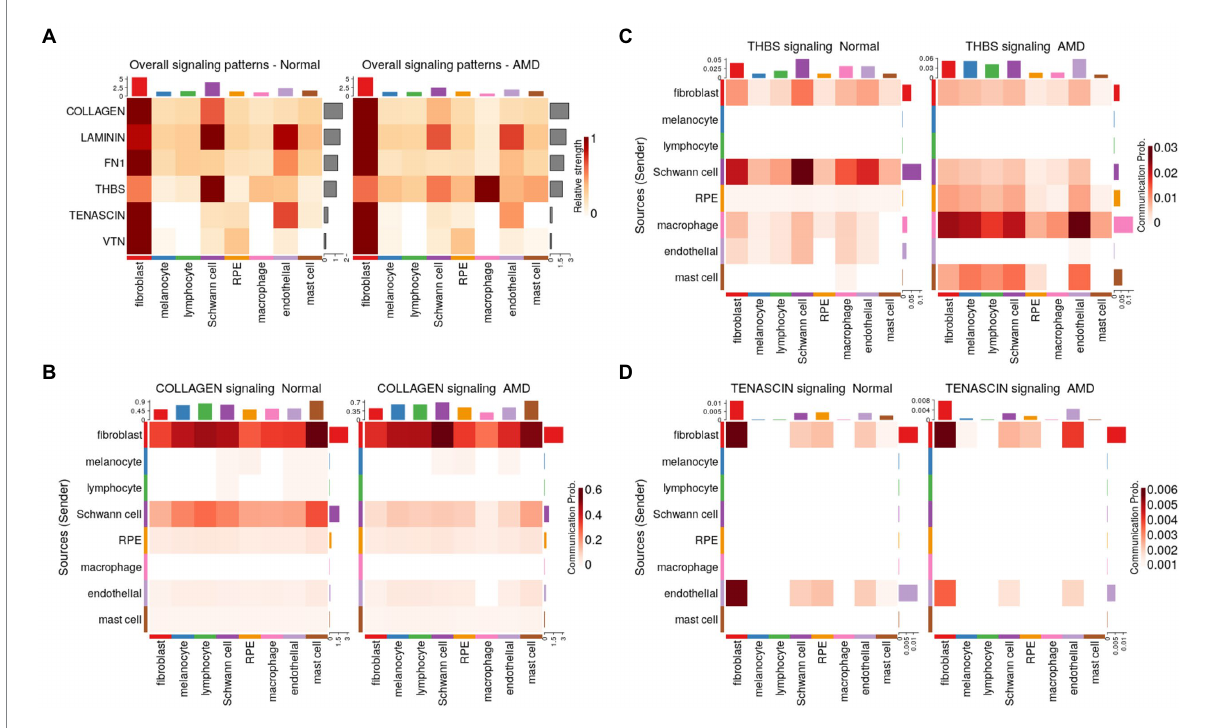
FIGURE 3 ECM-related signaling in the RPE/choroid derived from CellChat results. (A) Heatmap showing the relative strength of highly expressed ECM- related pathways across cell types in both normal and AMD tissues in the scRNA-seq dataset from Voigt et al. (2019). (B) Cell-type to cell-type heatmap of CellChat communication probabilities aggregated from each COLLAGEN LRI. COLLAGEN signaling was mostly originating from fibroblast and Schwann cells targeting all cell types similarly. (C) Cell-type to cell-type heatmap of CellChat communication